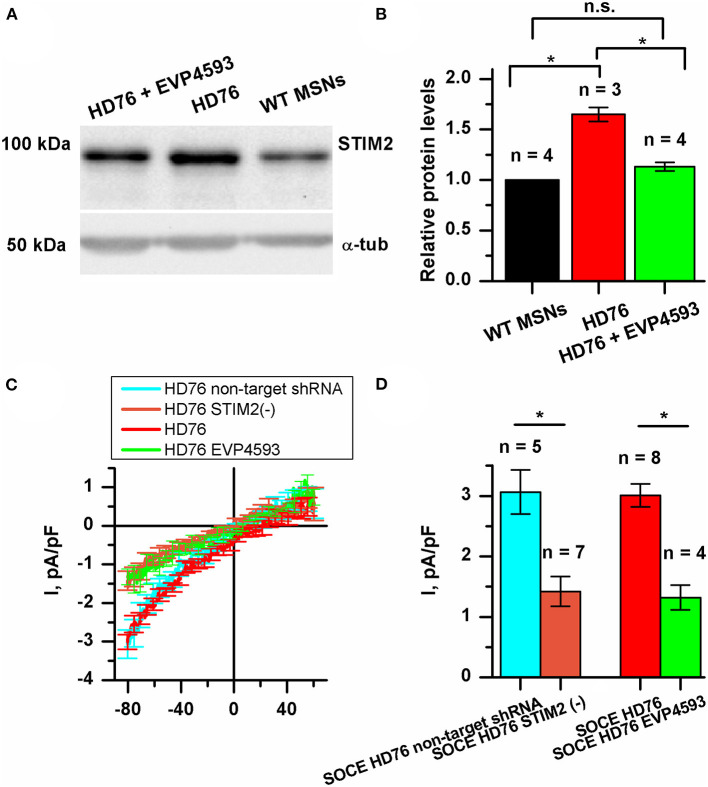
STIM2 as the cornerstone of significantly increased SOCE in HD76 GABA MSNs. (A) Representative Western blot showing the expression level of STIM2 in HD76, HD76 incubated with 300 nM EVP4593 for 24 h and WT GABA MSNs. Band intensities were quantified and values normalized to the α-tubulin housekeeping protein. (B) Relative STIM2 levels in HD76 (red), HD76 incubated with 300 nM EVP4593 (green) and WT GABA MSNs (black). Biological replicates are mentioned above the bars. (C) Average Current-Voltage relationships (I–V curves) of normalized currents evoked by passive depletion of calcium stores with thapsigargin (1 μM) in HD76 expressing non-target shRNA (HD76 non-target shRNA, cyan line), HD76 expressing shRNA against STIM2 (HD76 STIM2(–), orange line), intact HD76 (red line) and HD76 pre-incubated with 300 nM EVP4593 for 24 h (green line). The number of experiments is depicted at the panel (D). (D) Average amplitude or the normalized SOC currents determined at a test potential of −80 mV for HD76 expressing non-target shRNA (cyan), HD76 expressing shRNA against STIM2 (orange), intact HD76 (red) and HD76 pre-incubated with 300 nM EVP4593 for 24 h (green). The amplitudes are plotted as the mean ± SEM (n = number of single cell experiments). The asterisk indicates that differences in amplitudes are statistically significant (p < 0.05).